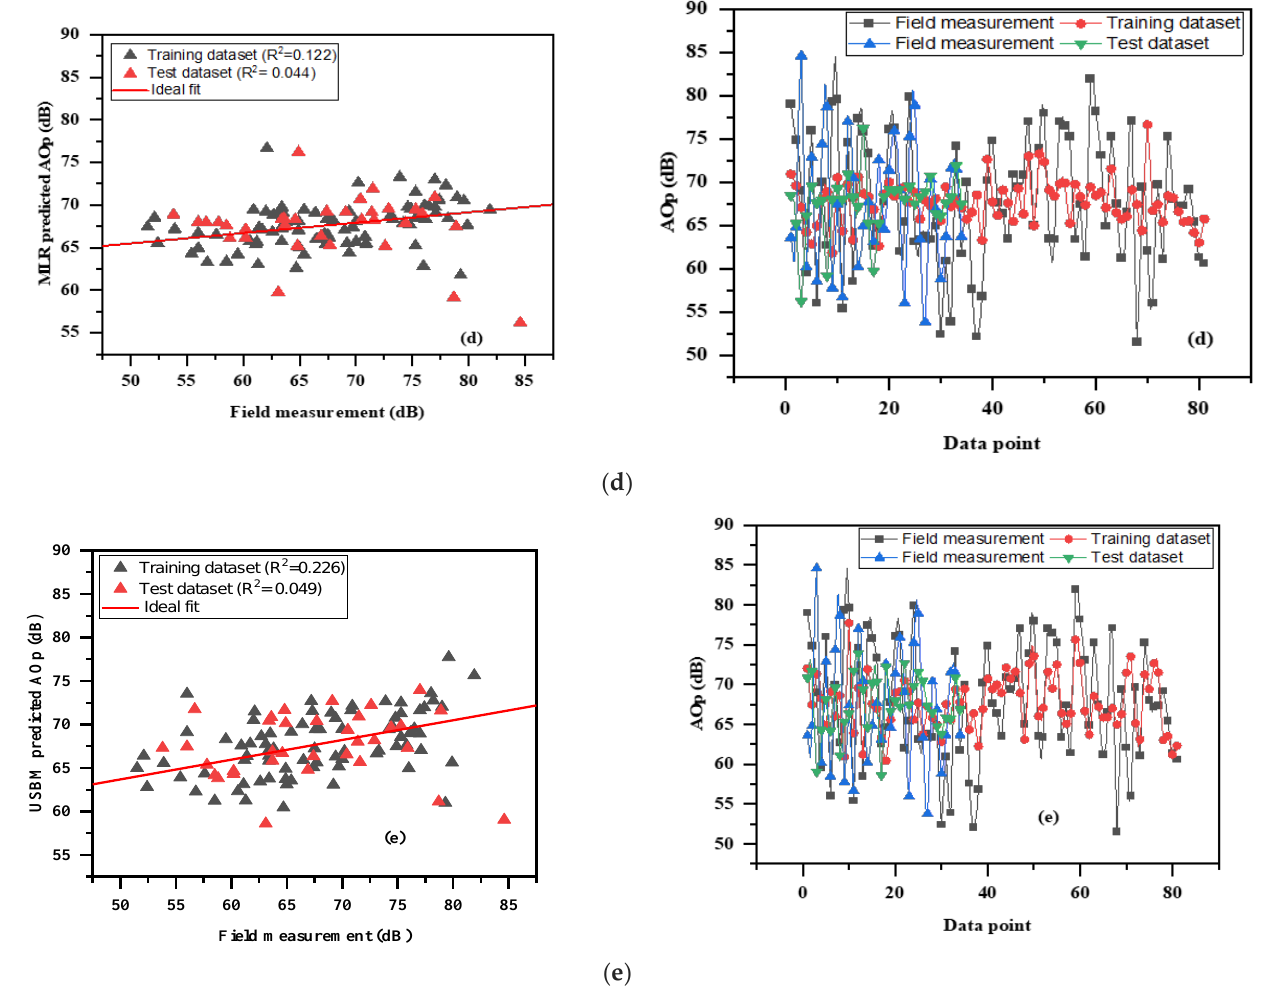
Figure 8. Developed AOp prediction model performances. ( a ) ANN model; ( b ) SMA-ANN model; ( c ) MVO-ANN model; ( d ) MLR model; ( e ) USBM model.